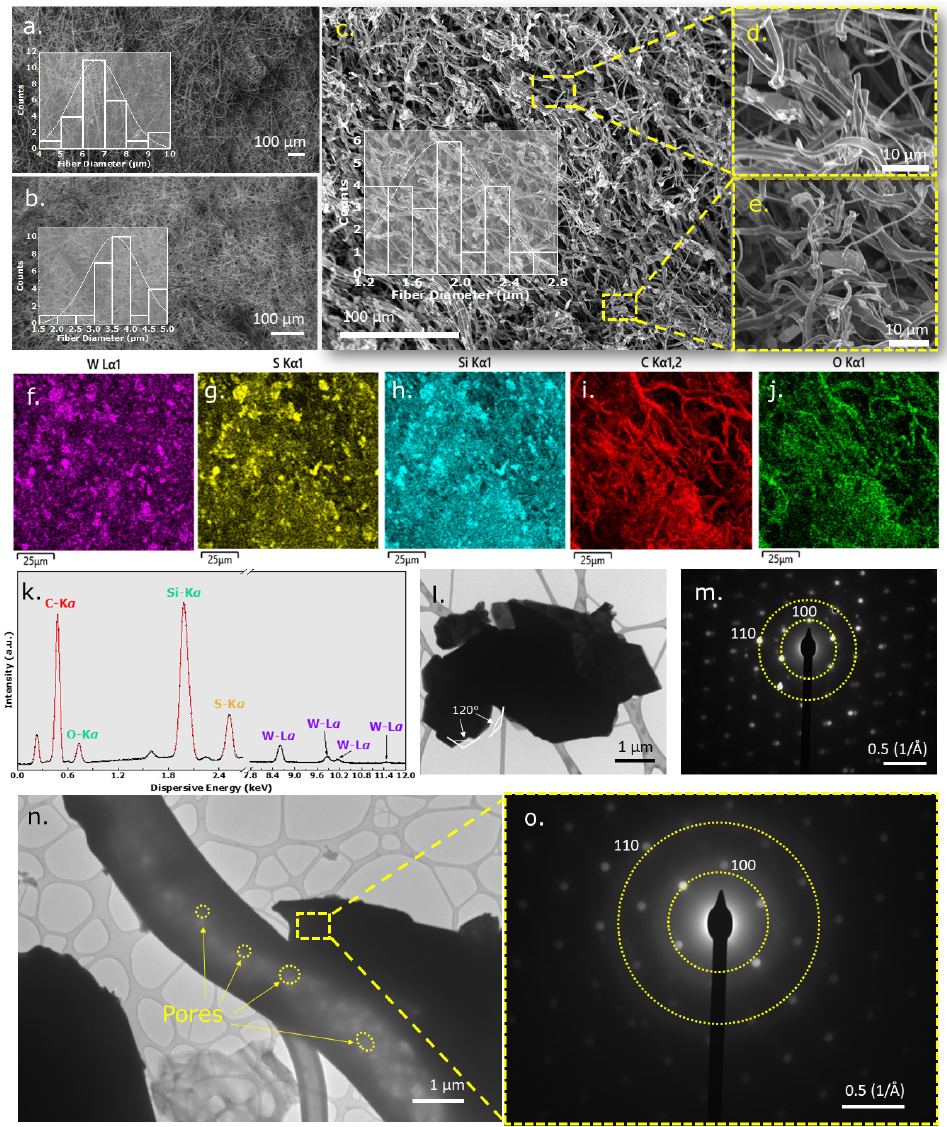
Figure 1. SEM micrograph of ( a ) as-spun WS 2 /SiOC fibermat confirming the fibrous structure of the fibermat; the inset showing the distribution curve of the average fiber diameter; ( b ) cross-linked WS 2 /SiOC fibermat confirming the fibrous structure of the fibermat; the inset showing the distribution curve of the average fiber diameter; ( c ) pyrolyzed WS 2 /SiOC fibermat confirming the fibrous structure of the fibermat; the inset showing the distribution curve of the fiber diameter; ( d ) magnified SEM micrograph of the pyrolyzed fibermat elucidating the individual fibers; ( e ) magnified SEM micrograph of the pyrolyzed fibermat showing WS 2 nanosheet dispersed in the SiOC matrix; the dotted lines